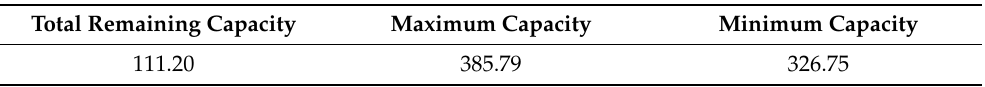
Table 7. Total remaining capacity and maximum and minimum capacity required for harmonic mitigation (kW).